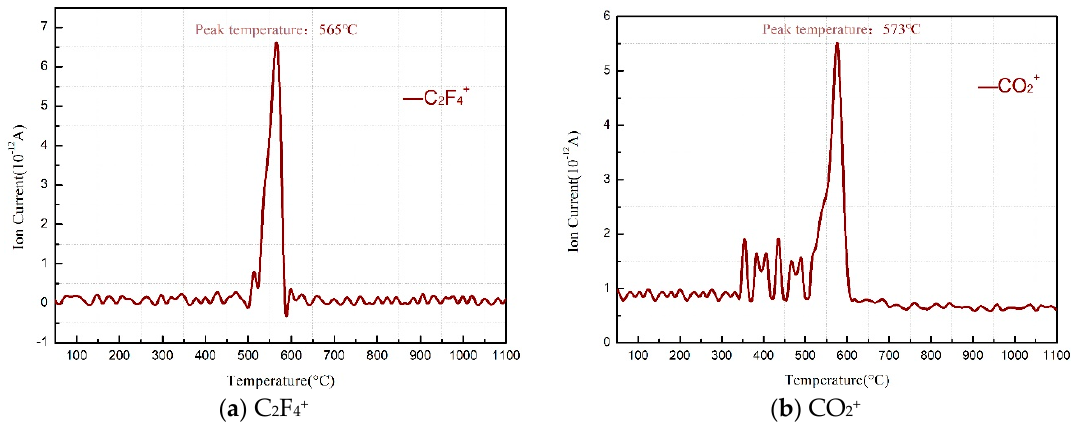
Figure 8. MS spectra of gaseous products from PTFE/Al/MnO 2 samples. ( a ) MS spectra of C 2 F 4+ ; ( b ) MS spectra of CO 2+ .